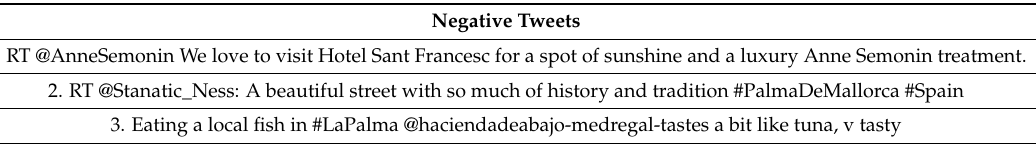
Table 11. Neutral tweets